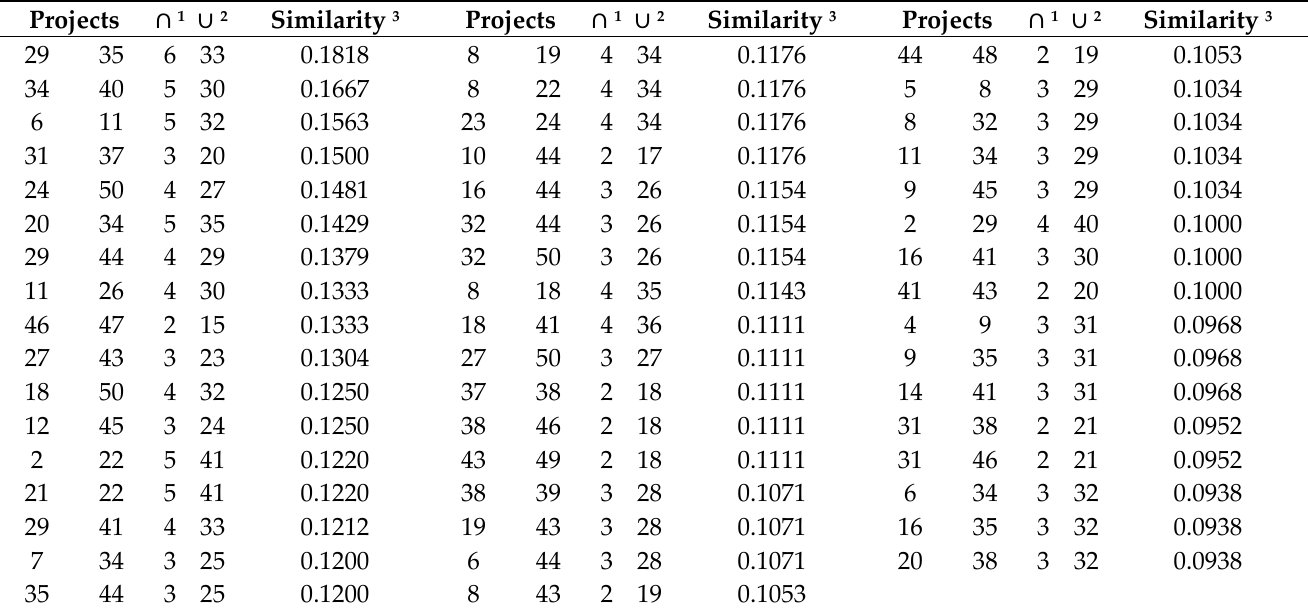
Table 3. Projects paired based on